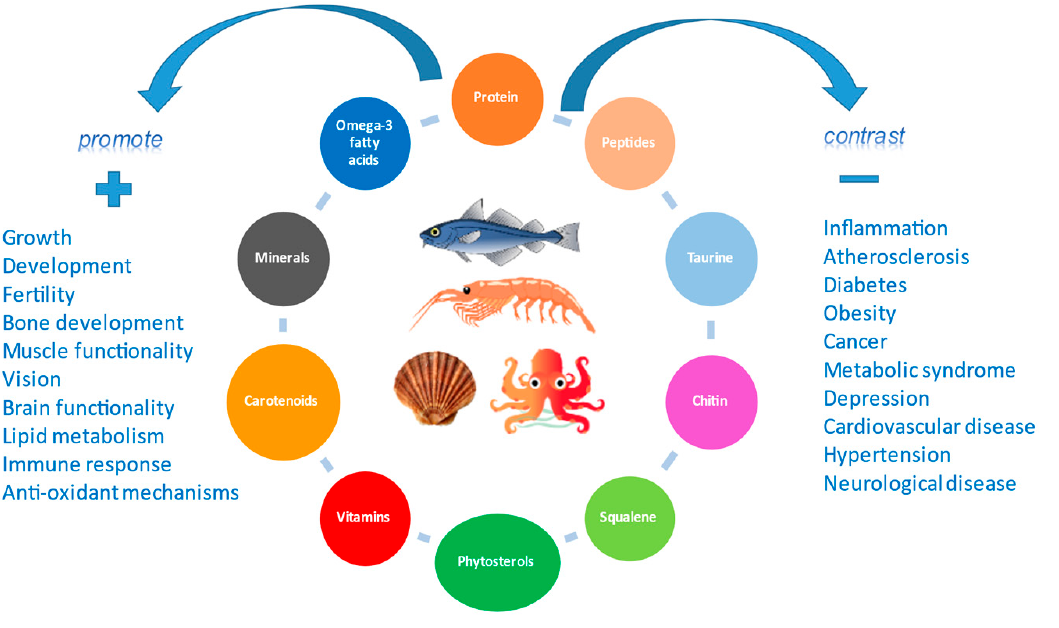
Figure 1. A graphical representation of the seafood/fish/nutrient/bioactive compound search with related health effects.